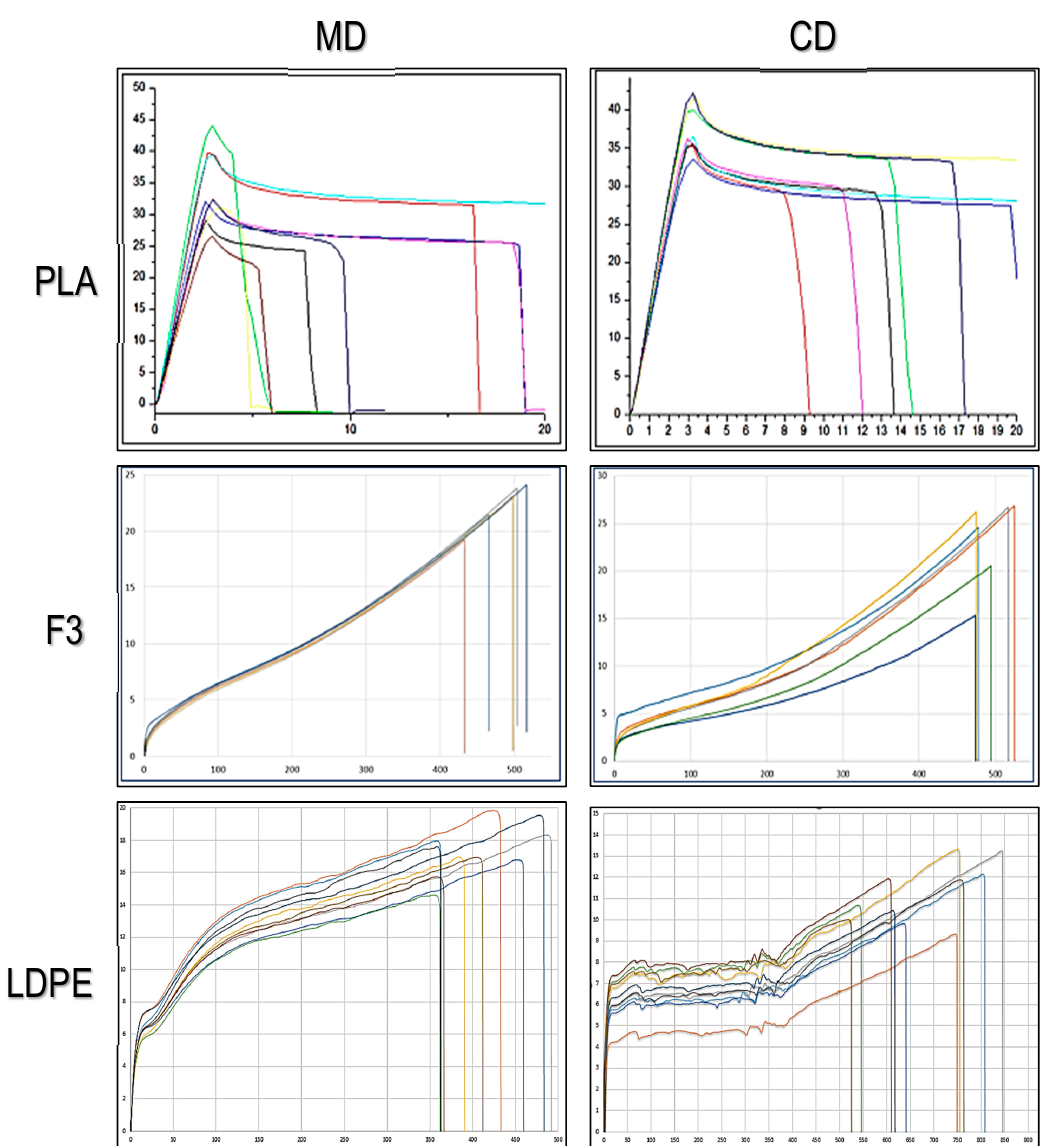
Figure 8. Stress/strain curves for PLAF3 and LDPE dumbbell taken from flat die films. On the vertical axis the stress in MPa is reported and on the horizontal axis the percentage of elongation.